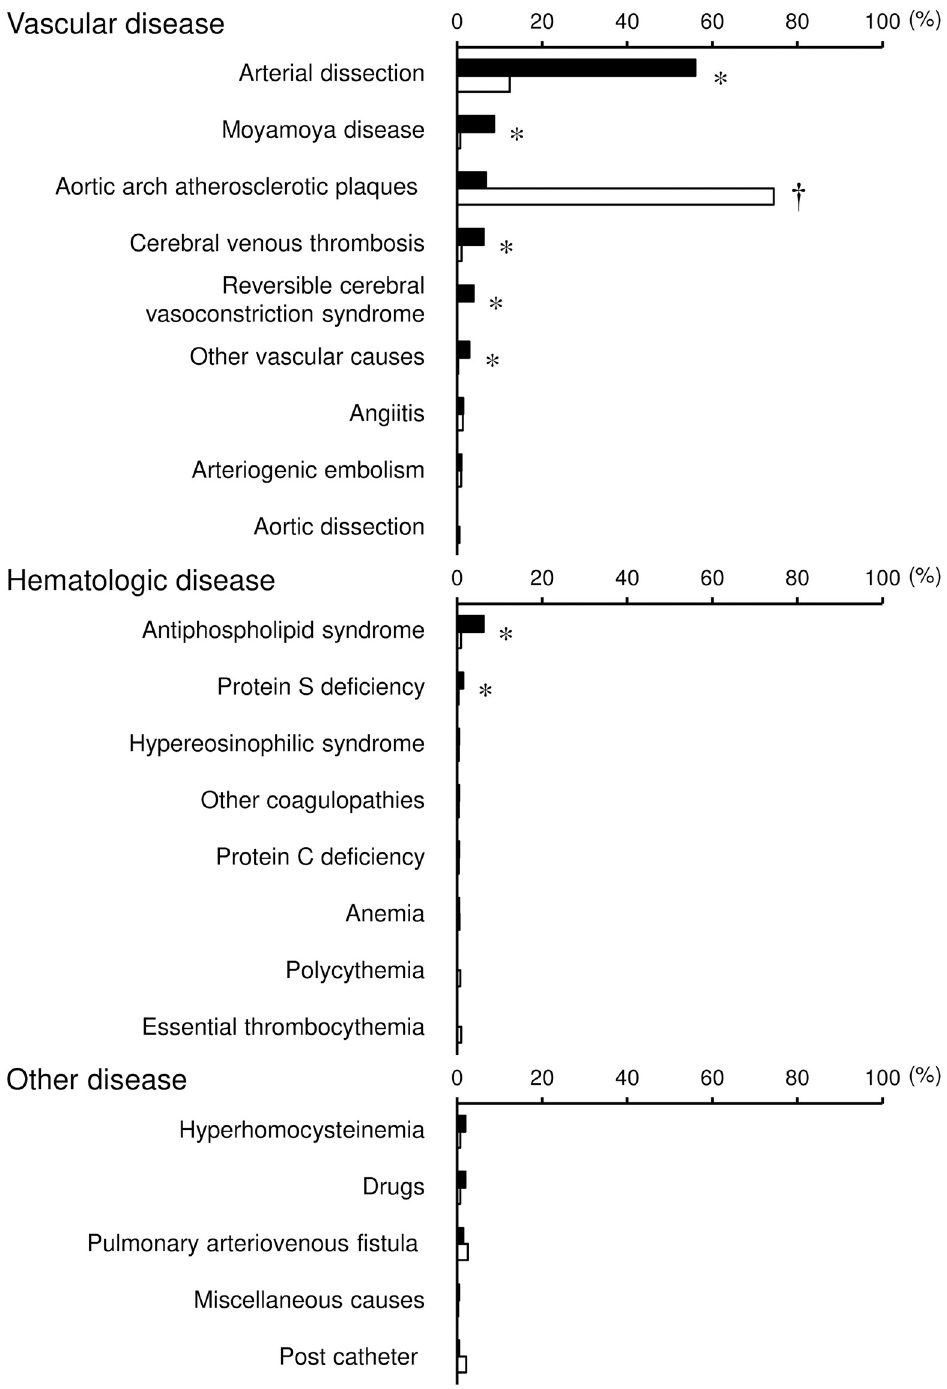
Fig 5. Frequency of uncommon causes in young adults and non-young adults. Frequency of uncommon causes in young adults (closed columns) and non-young adults (open columns) is shown according to origin (vascular disease, hematologic disease, and other disease) among patients with ischemic stroke due to other determined etiologies. When patients had multiple uncommon causes, all potential causes were listed. � P < 0.05, higher in young adults than in non-young adults. †P < 0.05, lower in young adults than in non-young adults.